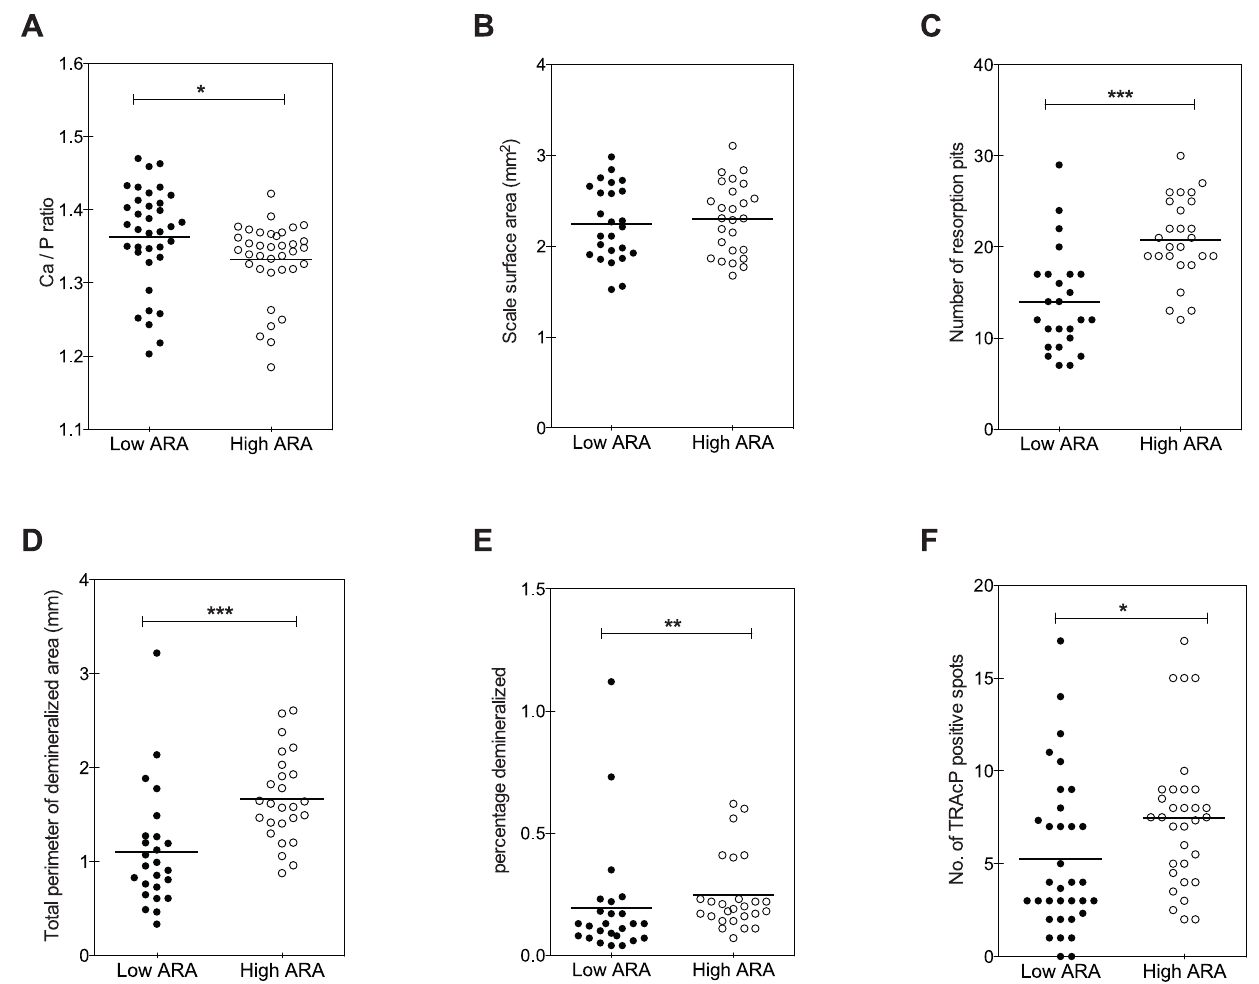
Figure 1. Effects of the different diets on scale mineralization. Analyses of the mineralized layer of ontogenetic scales were done after feeding the low ARA diet (solid dots) or the high ARA diet (open dots) for 4 weeks. A : Calcium:phosphorus molar ratios were significantly lower in high ARA fed fish. B : Surface area of the scales was unaffected. C : The number of resorption pits per individual scale was higher in the high ARA fed fish. D : Indeed, total perimeter of resorption pits also increased. E : Percentage of each scale that is demineralized (as a result of osteoclast activity) was also increased in high ARA fed fish. F : Number of TRAcP-stained regions per scale. Each replicate is shown; the horizontal lines represent means of 36 replicates. Statistical analysis was done with the Students T-test (*** p , 0.001) except for ( E ) which required non-parametric testing (Mann Witney-U test, ** p , 0.01).